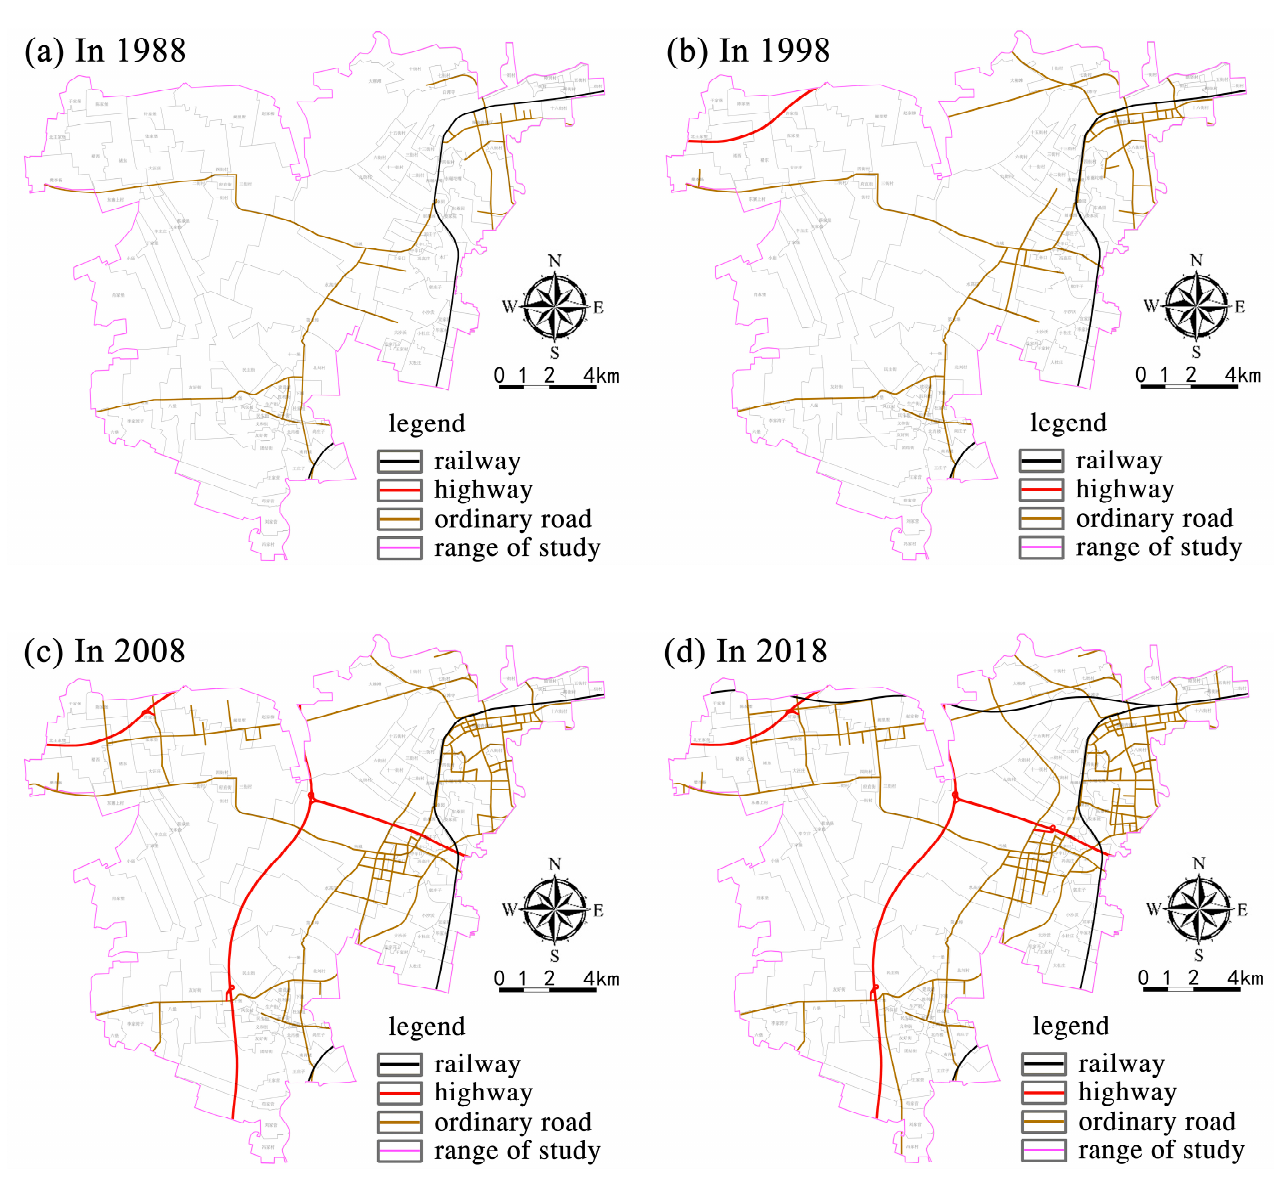
Figure 4. Changes in the rural external traffic network in the western suburbs of Tianjin during various periods of urban expansion (source: self-drawn).